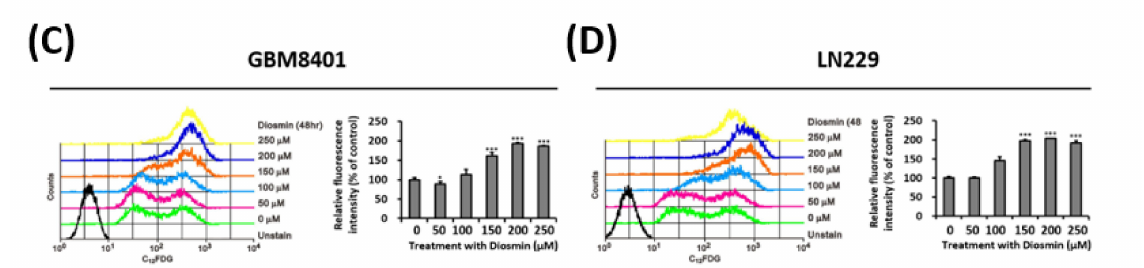
Figure 2. Diosmin induces G1 phase arrest and senescence in GBM cells. ( A , B ) Flow cytometric examination of the cell cycle after PI staining of control and diosmin-treated GBM8401 ( A ) and LN229 ( B ) cells. The cell percentages in each phase (subG1, G1, S, G2/M) were estimated with CellQuest software (Becton Dickinson). The results are derived from three independent experiments. * p < 0.05, ** p < 0.01, and *** p < 0.001 vs. controls by using the unpaired, two-tailed Student’s t -test. ( C , D ) Flow cytometric examination of the senescence after C 12 FDG labeling of control and diosmin-treated GBM8401 ( C ) and LN229 ( D ) cells. The data are shown as the mean ± S.D.; n = 3; *** p < 0.001 compared to the control group.